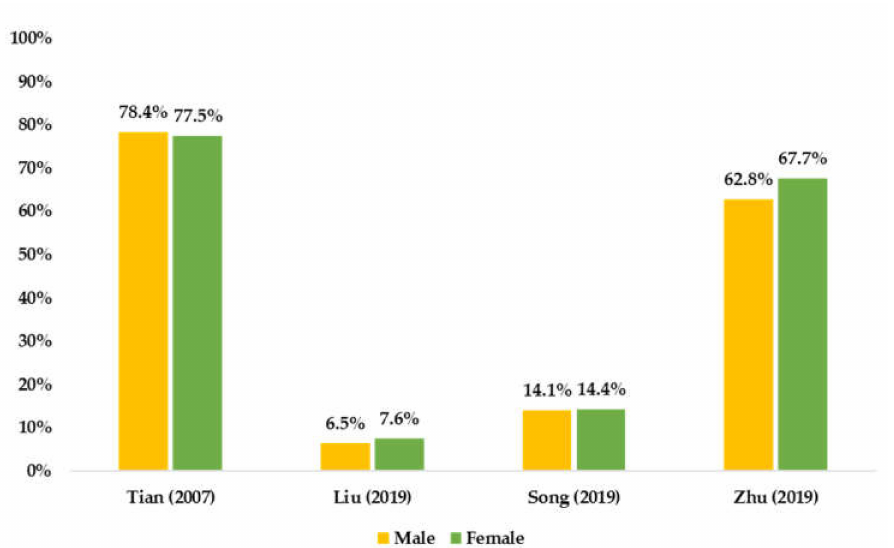
Figure 4. Summarized available prevalence of SB by sex among Chinese children and adolescents.